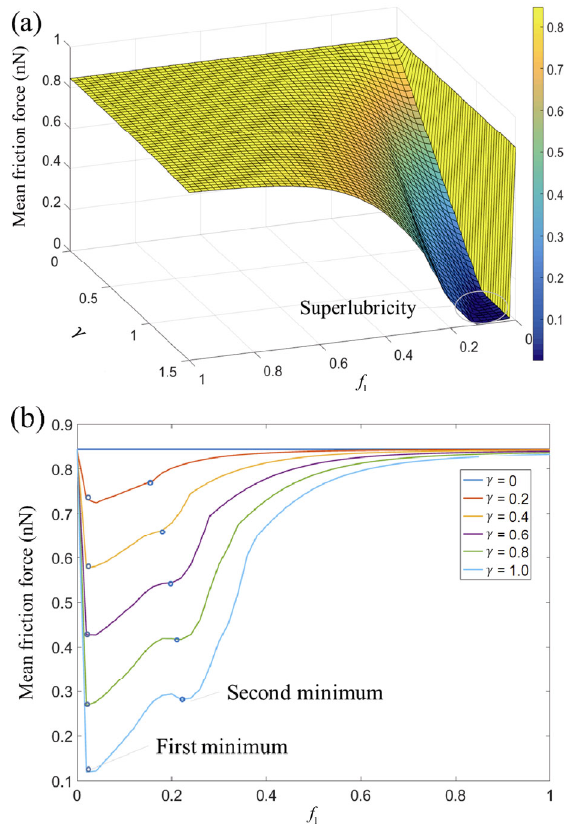
Fig. 13 Dependence of the mean F on  and and (b) dependence details of friction on